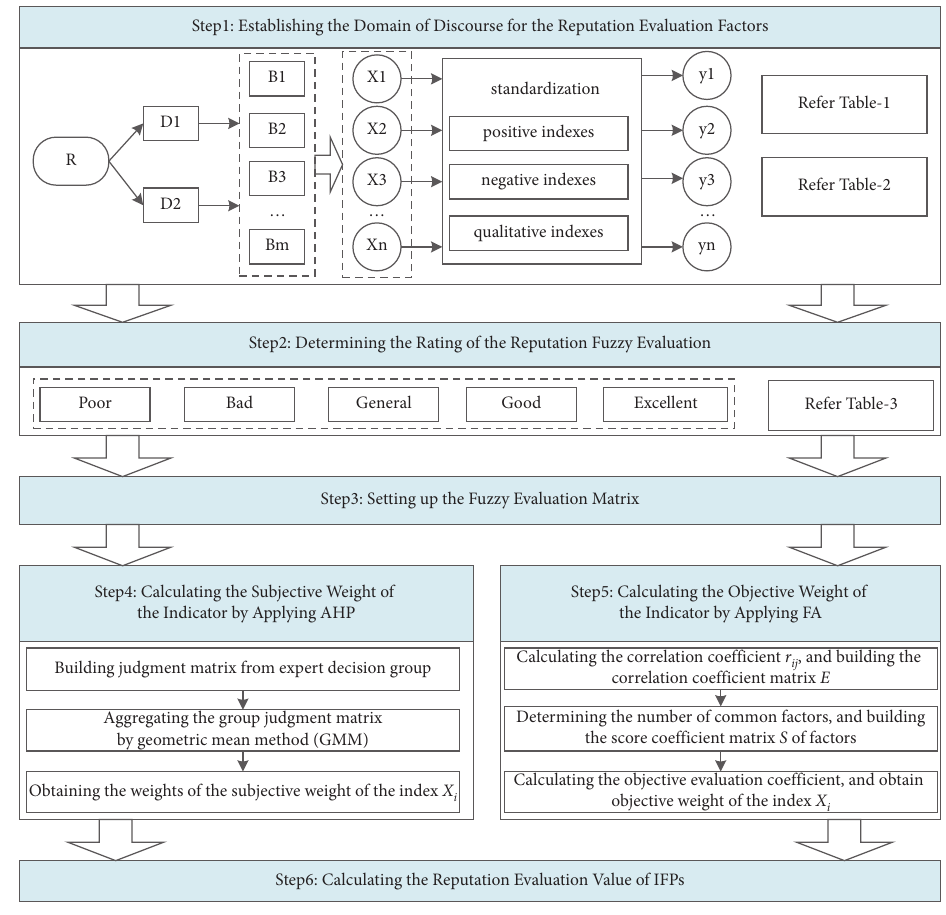
Figure 1: The framework of IFEA for evaluating reputation of IFPs. Table 2: The scoring criteria for qualitative